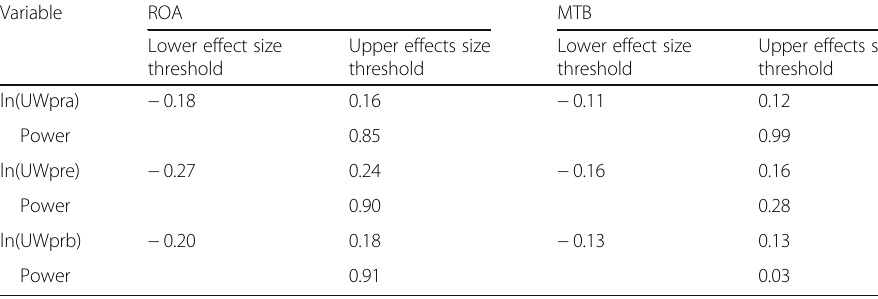
Table 6 Effect sizes and expost-post power test